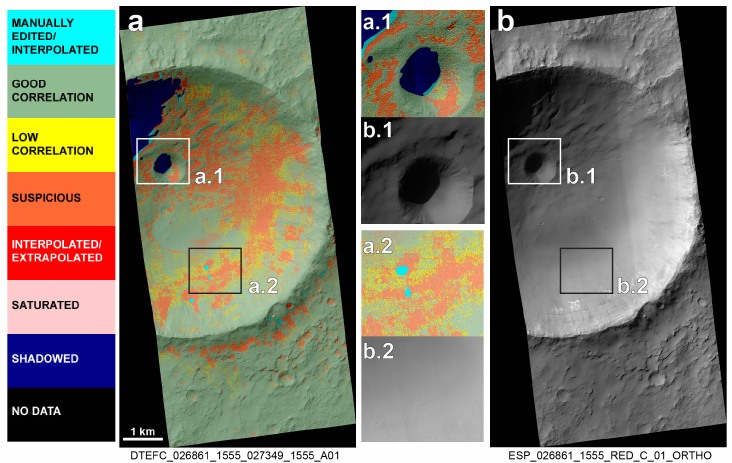
Figure 6. Example of a Figure of Merit (FOM) map, legend, and orthoimage. North is up and illumination is from the upper left in all images. ( a ) FOM map showing the classified map including deeply shadowed areas, which resulted in no reliable elevation data. ( b ) One of the corresponding orthoimages from the stereo pair. ( a.1 ) Detail of shadowed crater in the FOM map. ( b.1 ) Detail of orthoimage illustrating deeply shadowed portion of the small crater that resulted in the “Shadowed” classification in the FOM. ( a.2 ) Detail of FOM map showing areas of Low Correlation, Suspicious, and Manually Edited areas. ( b.2 ) Corresponding area in the image to illustrate that the low correlation FOM values likely arose from the featureless, bland, low-contrast